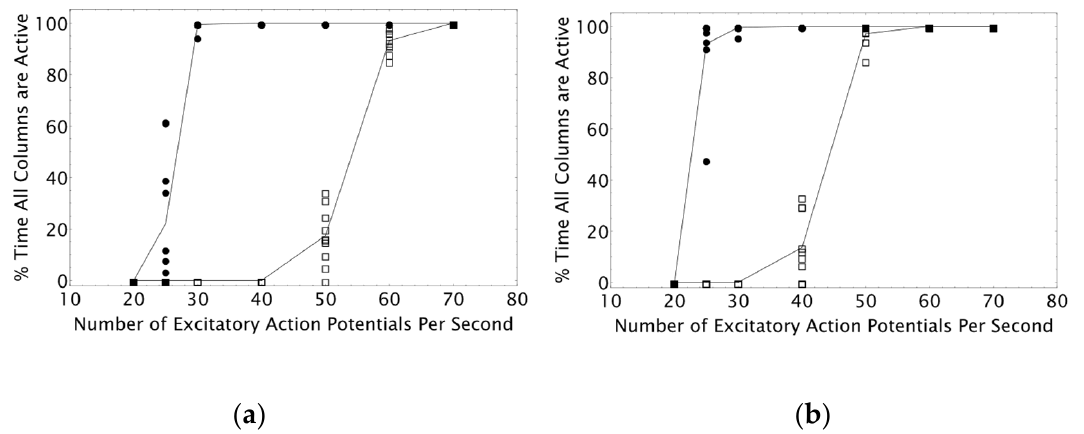
Figure 4. The percentage of the final 900 ms of each of 10, 1 s segments of 10 s simulations during which excitatory (closed disks) and inhibitory (open squares) neurons in all 25 columns are producing non-zero values in synaptic conductance in target neurons. Lines join values averaged over the 10, 1 s intervals. Panel ( a ) depicts data in the absence of simulated stimulation and panel ( b ) shows data in the presence of simulated stimulation of column 1 neurons.